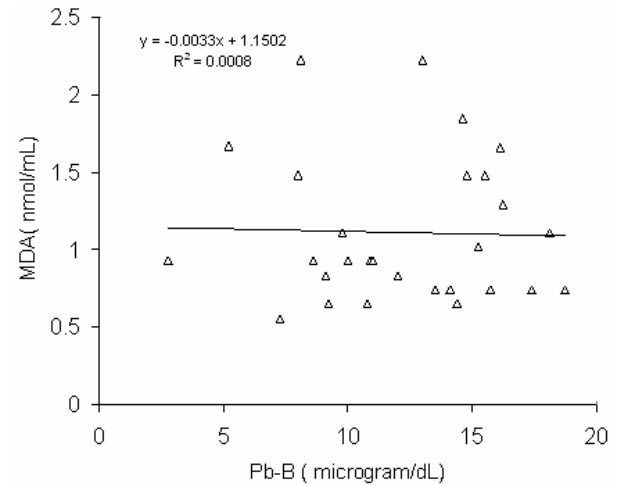
Figure 7: Relationship between blood lead concentration (Pb-B; range is 2.8 -22.0µg/dl) and serum malondialdehyde (MDA) level of control group of subjects belong to Western Maharashtra (India); n = 35, Correlation coefficient (r) is 0.028, p> 1.0, Not significant; y = -